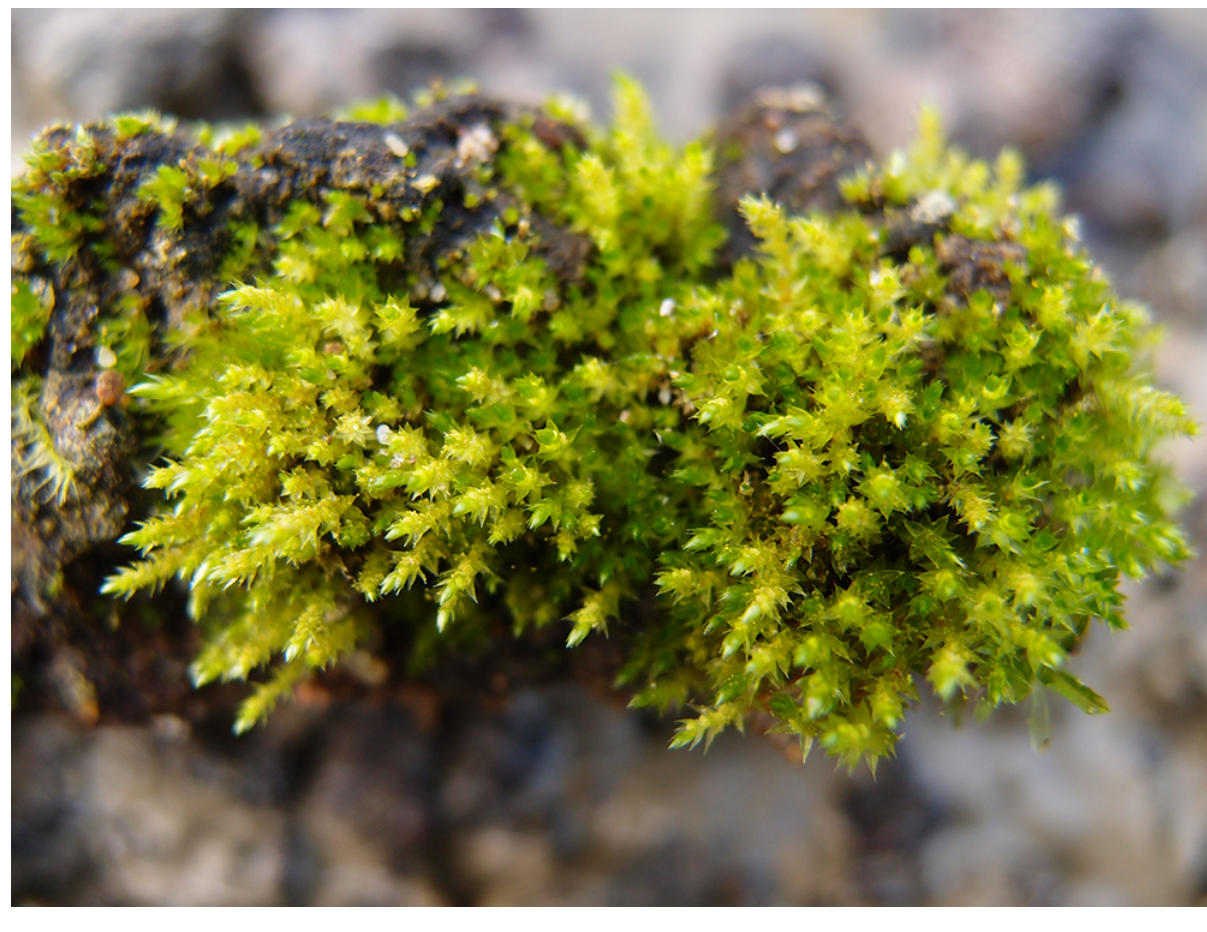
Figure 1 Characteristics of the plants from Ruska Strona (photo P. Kalinowski, September 11,